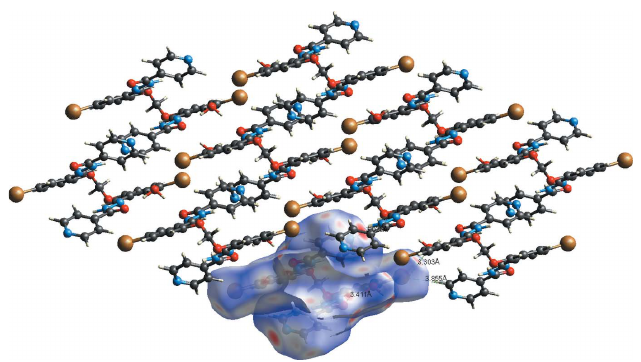
Figure 7 A view of the Hirshfeld surface mapped over d norm of compound (I), showing the various intermolecular contacts in the crystal.